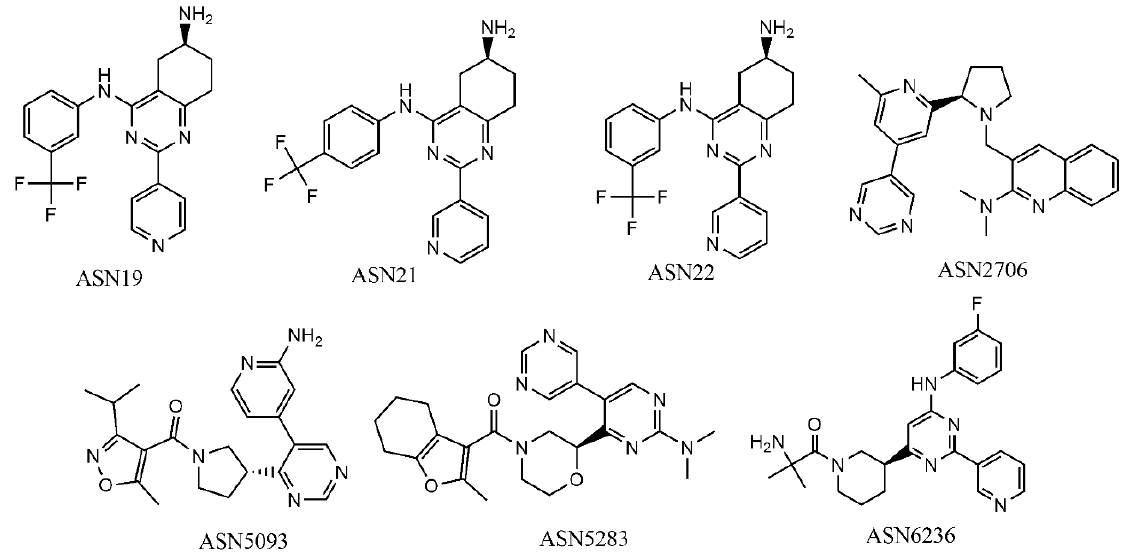
Figure 4. Structures of the most potential virtual hits obtained with the GA ‐ LDA and Xgboost models. Table 8. Number of experimental conditions pertaining to the most potential virtual hits gathered by the GA-LDA and Xgboost